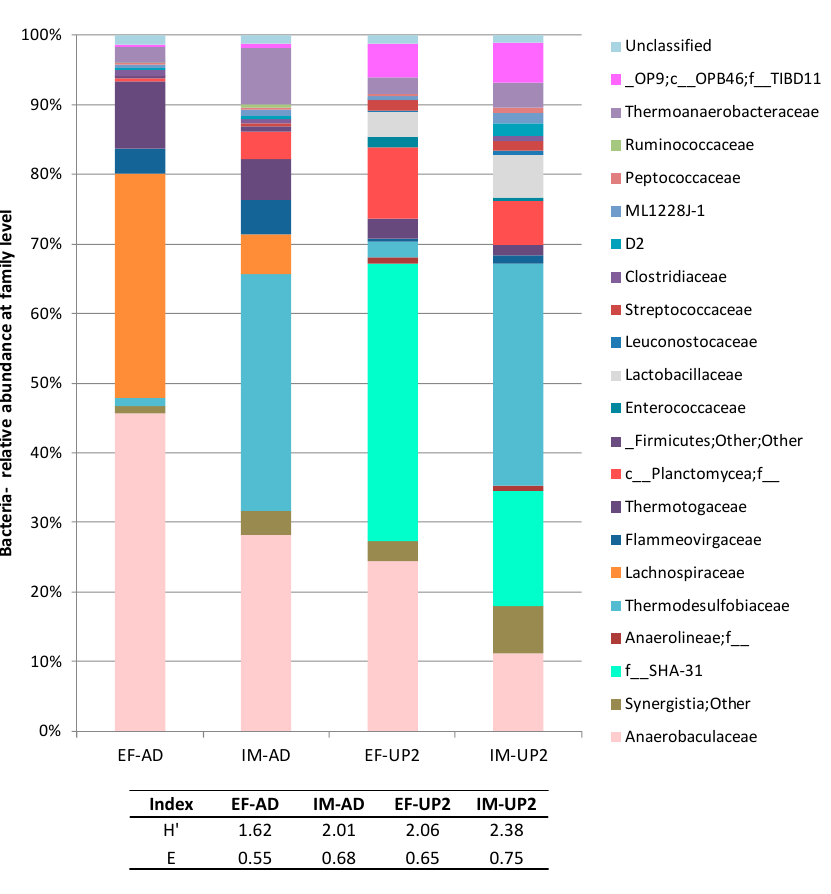
Figure 5. Relative abundances of the bacteria community at the family level at the end of AD (anaerobic digestion) and UP2 (H 2 injection) phases. Communities with a relative abundance ≥ 0.5% (in at least one sample) are reported. EF, effluent and IM, interstitial matrix. Table shows Shannon–Weaver (H’) and Pielou’s evenness (E) diversity indices.